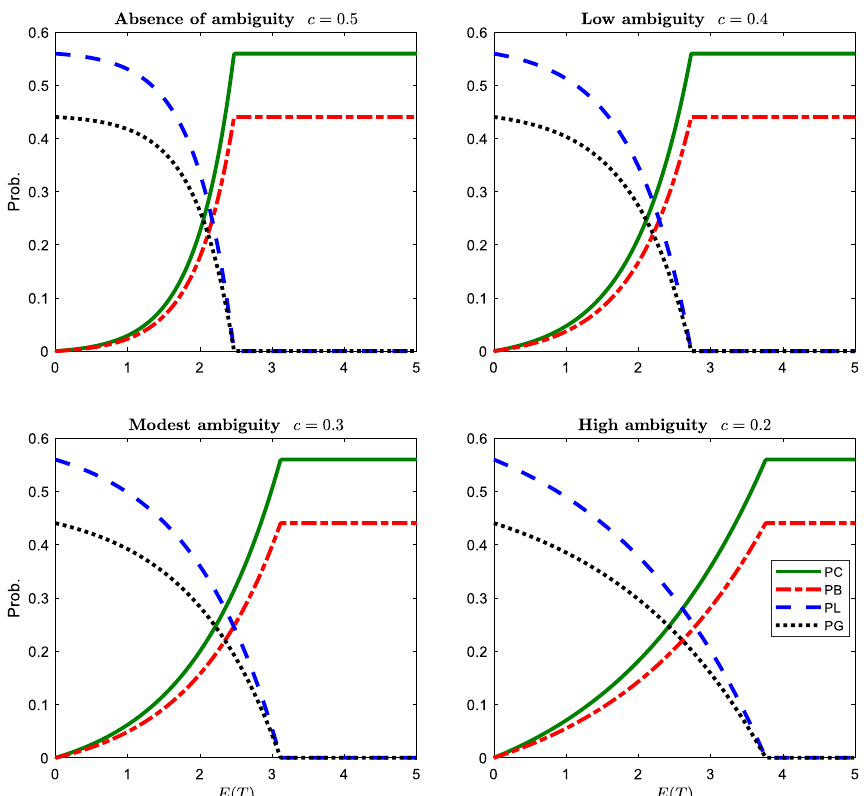
Fig. 2 Probabilities of the four strategies under ambiguity when the expected arrival time, E ( T ) , varies. PC , PB , PL , and PG represent the probabilities of pursuing compulsive, buy‑and‑hold, leapfrog, and laggard strategies, respectively. The parameter c represents the degree of ambiguity perceived by managers. When c = 0.5 , ambiguity is absent, implying that managers are neutral toward ambiguity. The upper left figure shows Fig. 1 of Grenadier and Weiss (1997). As c decreases, the degree of ambiguity increases. When c = 0.2 , the degree of ambiguity is the highest. Leapfrog and laggard strategies dominate in a market with rapid innovation (low E ( T ) ), whereas compulsive and buy‑and‑hold strategies dominate in a market with slow innovation (high E ( T )